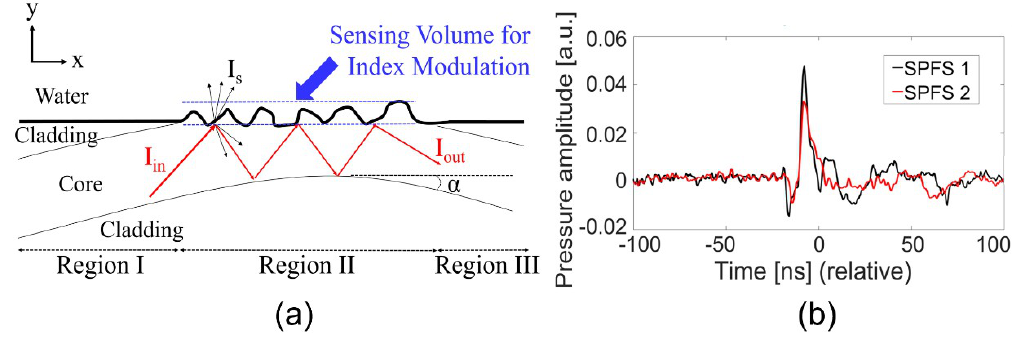
Figure 3. ( a ) A schematic diagram showing SPFS operation ( α = 0.114 ◦ ). The sensing volume increases with polish-induced roughness at the core surface. ( b ) Acoustic signal waveforms for two sensors with different roughness. The signal-to-noise ratio (SNR) increases with the roughness (in this example, 17.4 and 15.74 dB for SPF1 and SPF2,